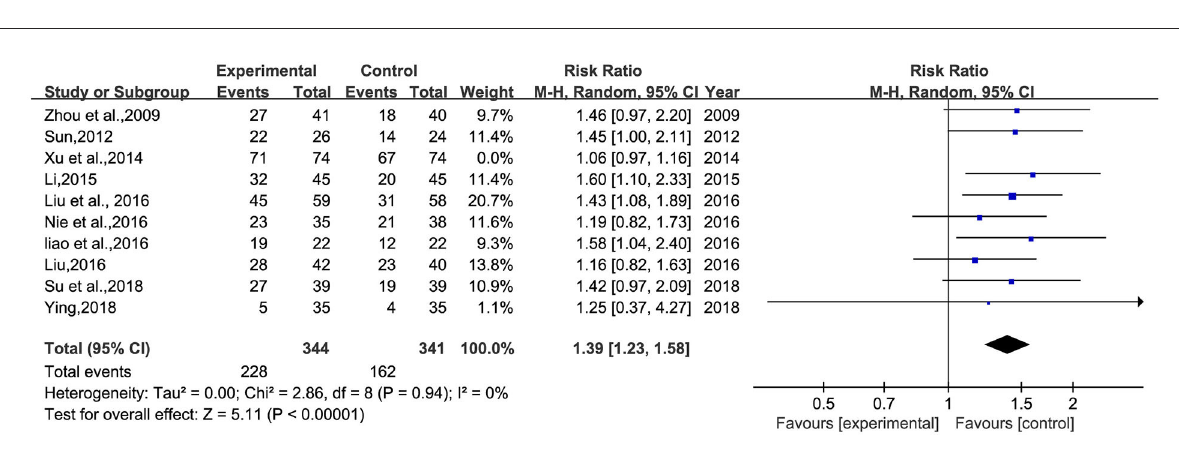
= 0.001, I 2 = 63%), and a meta-analysis was performed